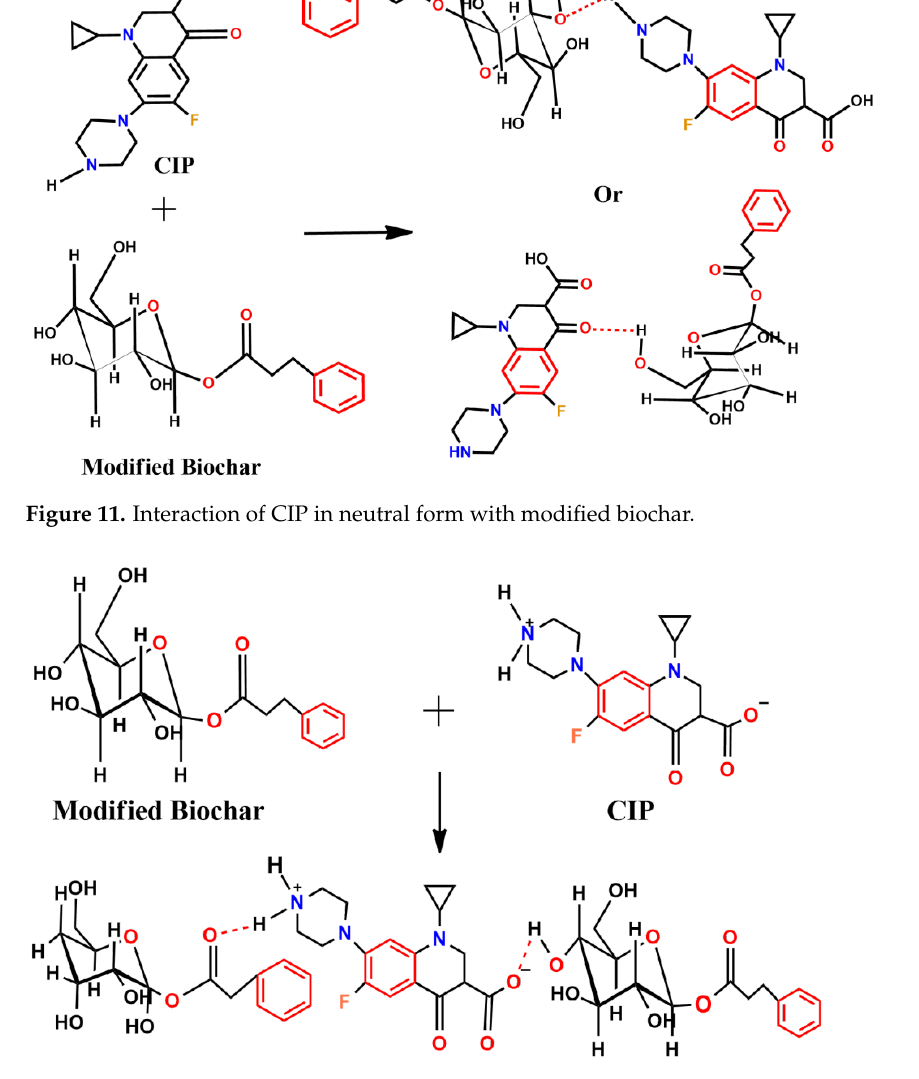
Figure 12. Interaction mechanism of CIP in zwitterion form with modified biochar. Table 3. HOMO and LUMO energy values and other parameters.